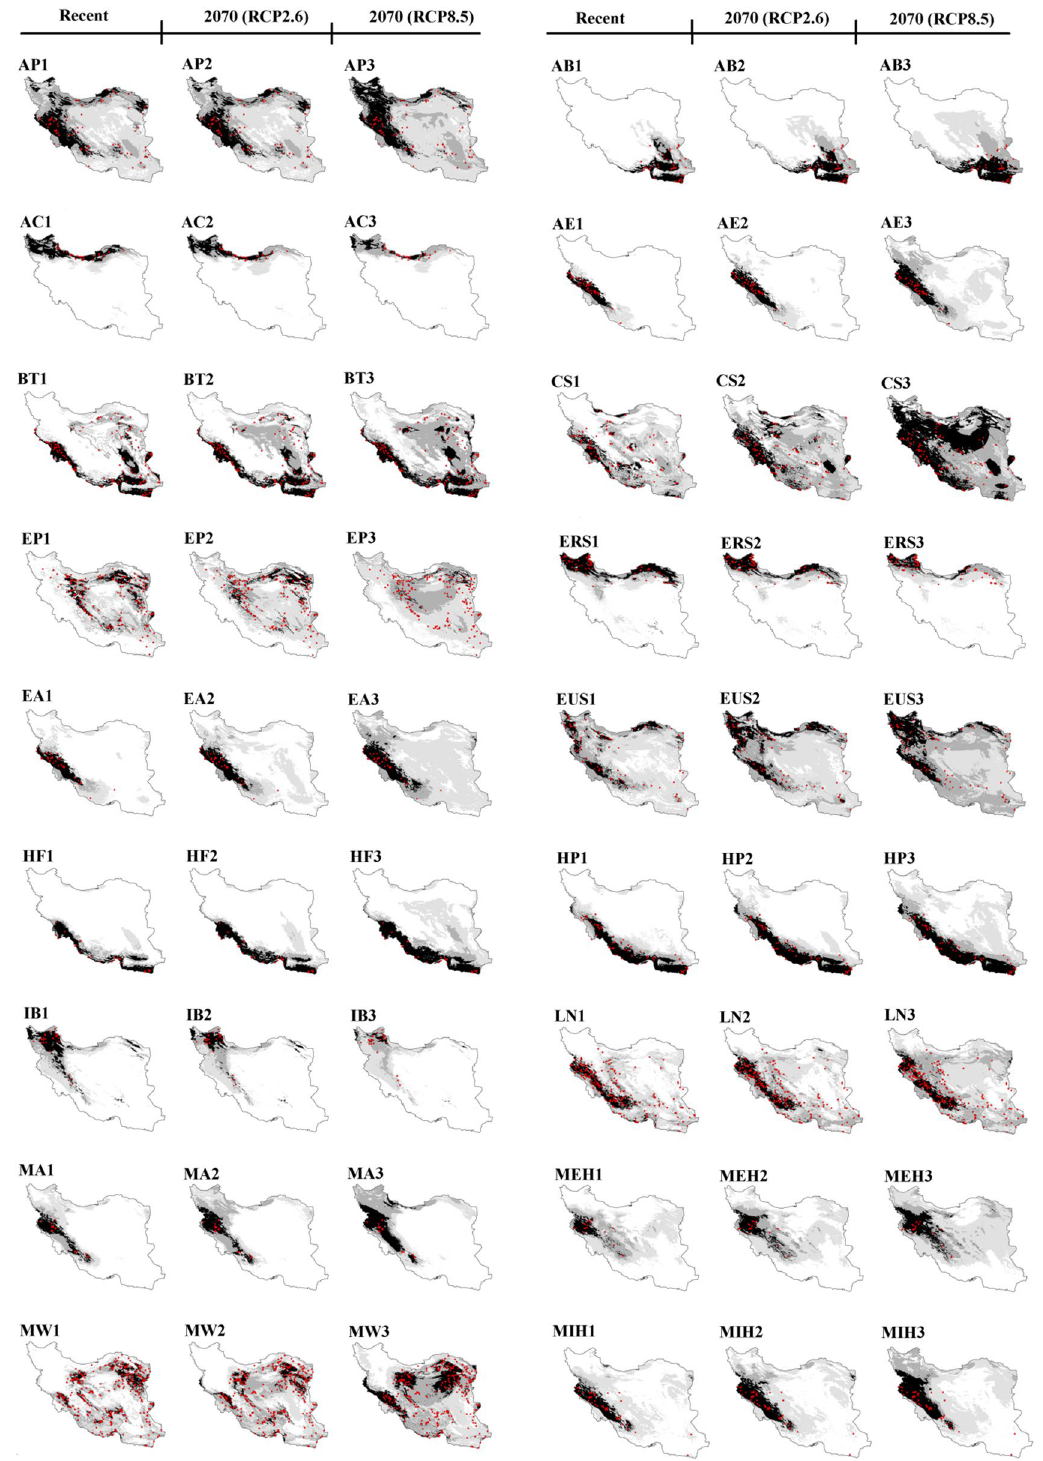
Figure 2. Recent and future (2070) habitat suitability (%) for 30 lizard species based on the consensus model under optimistic (RCP2.6) and pessimistic (RCP8.5) scenarios in Iran. (AP) Ablepharus pannonicus ; (AB) Acanthodactylus blanfordii ; (AC) Anguis colchica ; (AE) Asaccus elisae, (BT ) Bunopus tuberculatus ; (CS) Cyrtopodion scabrum ; (EP) Eremias persica ; (ERS) Eremias strauchi; (EA) Eublepharis angramainyu ; (EUS) Eumeces schneideri ; (HF) Hemidactylus flaviviridis ; (HP) Hemidactylus persicus ; (IB) Iranolacerta brandtii ; (LN) Laudakia nupta ; (MA) Mediodactylus aspratilis ; Mediodactylus heterocercum (MEH); (MW) Mesalina watsonana ; (MIH) Microgecko helenae ; (ML) Microgecko latifi ; (MP) Microgecko persicus ; (OE) Ophisops elegans ; (PC) Paralaudakia caucasia ; (PM) Phrynocephalus maculatus ; (PP) Phrynocephalus persicus ; (PS) Phrynocephalus scutellatus ; (TC) Tenuidactylus caspius ; (TP) Timon princeps ; (TS) Trachylepis septemtaeniata ; (TA) Trapelus agilis ; (TR) Trapelus ruderatus . Maps were generated using ArcMap (v 10.8) (https:// deskt op. arcgis.